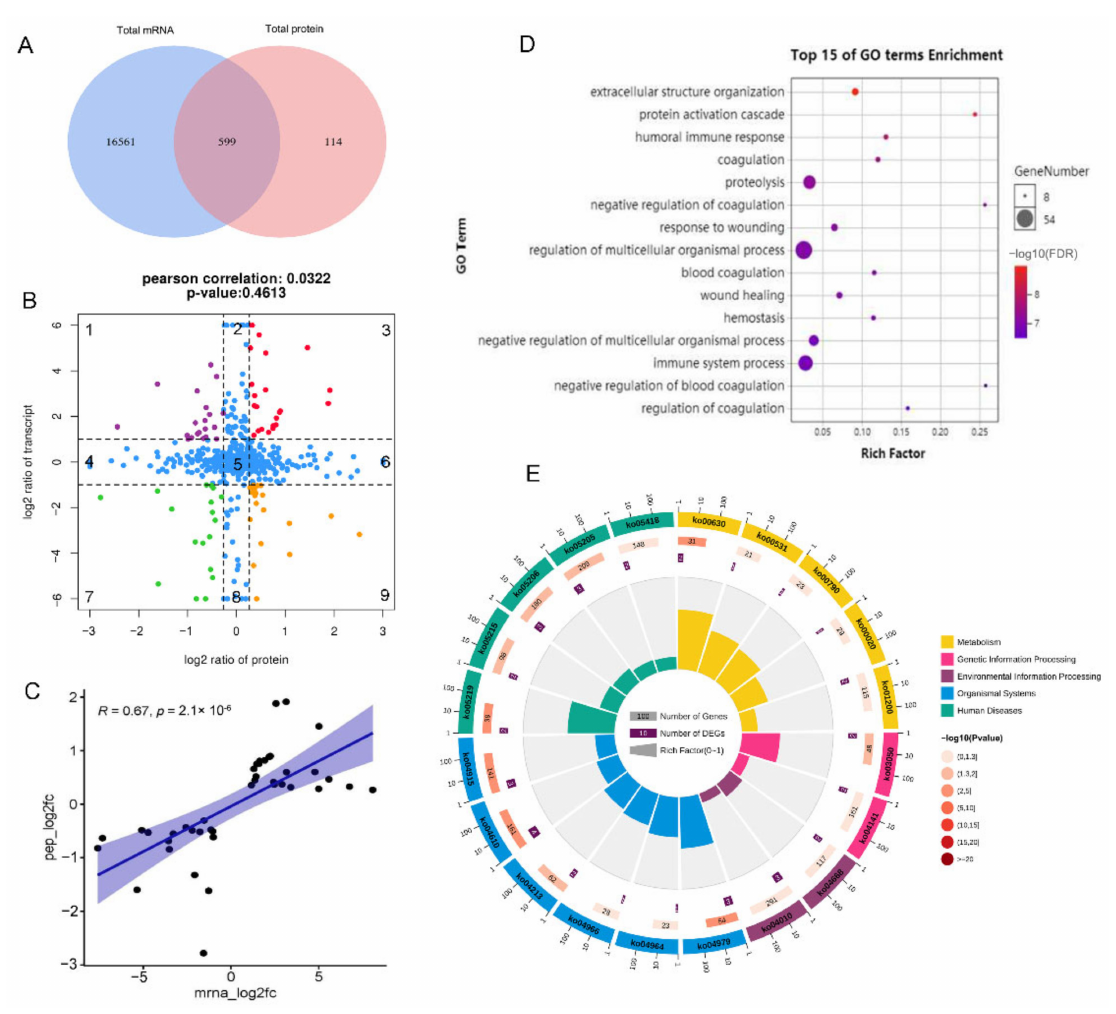
Figure 4. Expression concordance of proteotranscriptomic results between M and LW pigs. ( A ) Venn diagram of the gene set identified both in transcriptome and proteome. ( B ) Nine-quadrant diagram of mRNA-proteins pairs. ( C ) Gene correlation analysis in quadrants 3 and 7. ( D ) Bubble diagram of partial biology progress GO term clusters of quadrants 3 and 7. ( E ) Bar diagram of significantly enriched pathways for quadrants 3 and 7. The mRNA-proteins pairs with log2 ratio in quadrant 1 were represent in purple, in quadrant 3 were represent in red, in quadrant 7 were represent in green, in quadrant 9 were represent in orange, and in quadrant 2, 4, 5, 6 were represent in